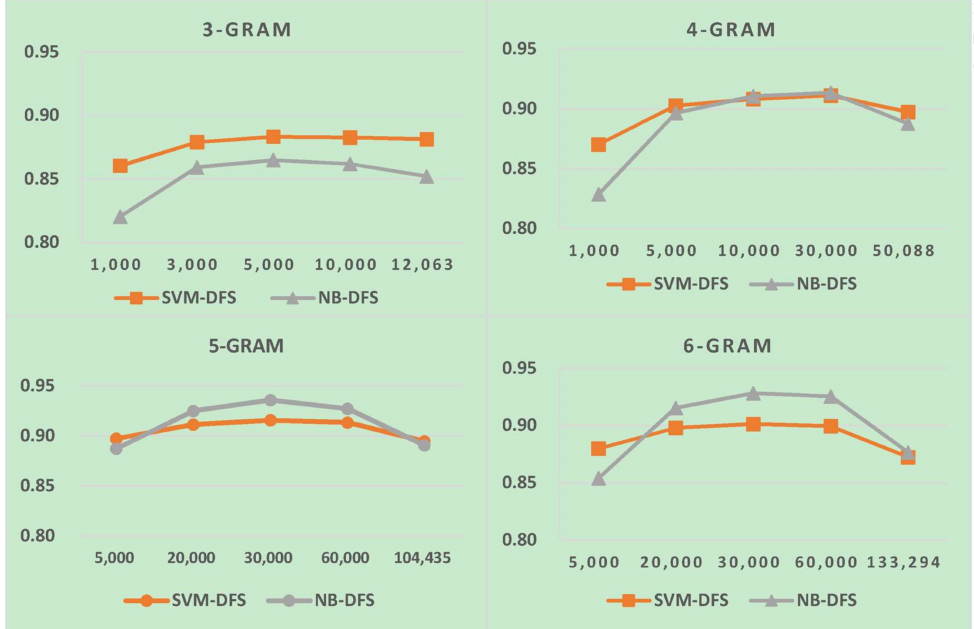
Figure 12. LI in similar language groups (SLG) including bos and hrv.